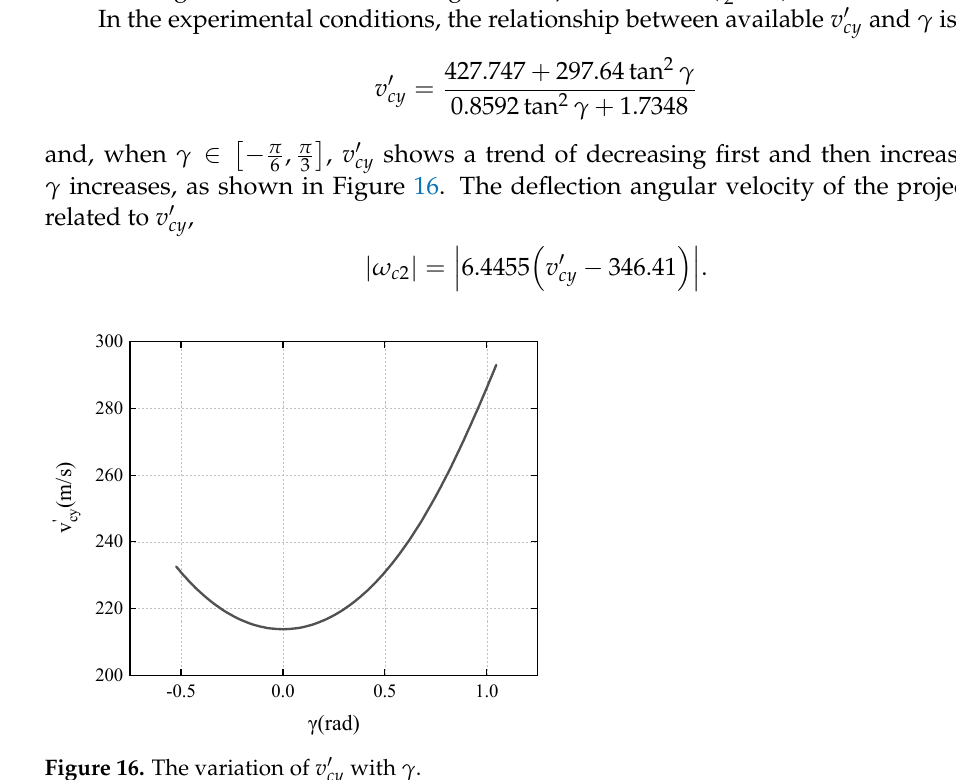
From impact point 1 in Figure 10 to the bottom edge of the 60° angle of the diamond, the deflection angle of the diamond-shaped moving target on the projectile shows a ten- dency to increase first and then decrease, and the worst deflection effect is at the bottom edge of the 60° angle of the diamond. It can be speculated that if a hexagonal moving target is used, the target area with poor deflection effect can be significantly reduced. 4.3. The Influence of Moving Target When 𝑣 = 400 m/s , 𝛾 = − (cid:3095) (cid:2874) , the relationship between the 𝑣 (cid:3030)(cid:3052) (cid:4593) and the 𝐽 (cid:3009) is: 𝑣 (cid:3030)(cid:3052)(cid:4593) = (cid:2871)(cid:2875)(cid:2868).(cid:2877)(cid:2871)(cid:2874)(cid:3011) (cid:3257) (cid:2878)(cid:2875).(cid:2873)(cid:2868)(cid:2871)(cid:2870) (cid:2868).(cid:2868)(cid:2870)(cid:2869)(cid:2874)(cid:2874)(cid:2878)(cid:2869).(cid:2875)(cid:2871)(cid:2872)(cid:2876)(cid:3011) (cid:3257) .